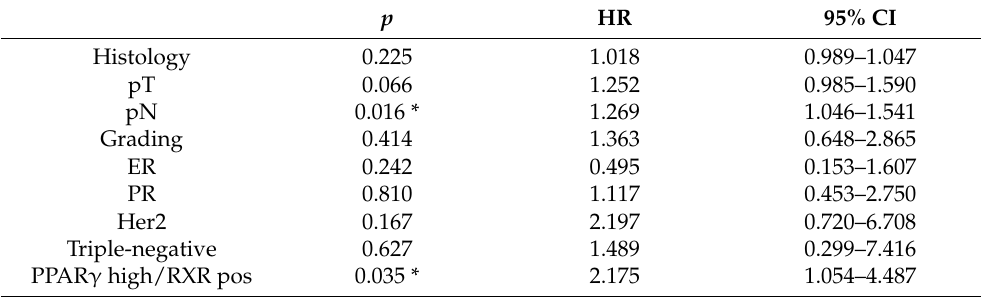
Table 4. Cox multivariate analysis for positive RXR α /high expression PPAR γ in the whole cohort.